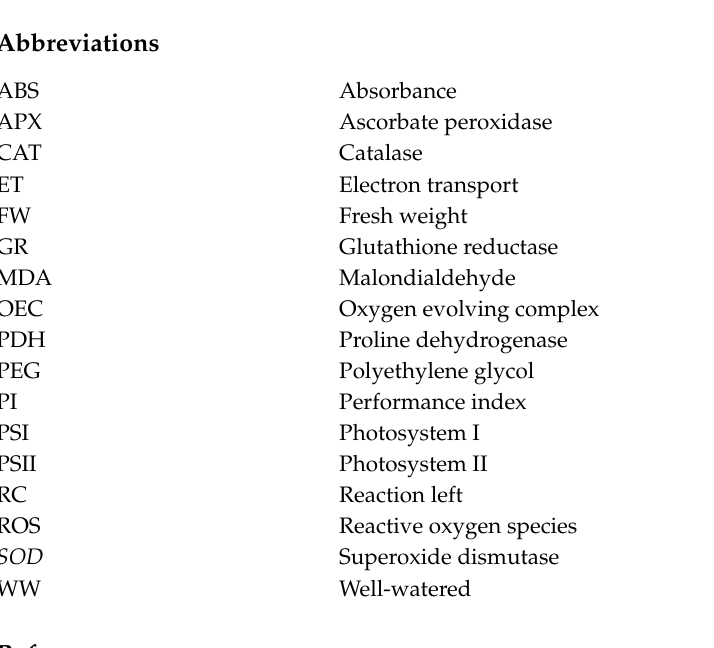
Table S1: Formulae and glossary of terms used by the JIP-test for the analysis of Chl a fluorescence transient OJIP emitted by dark-adapted photosynthetic